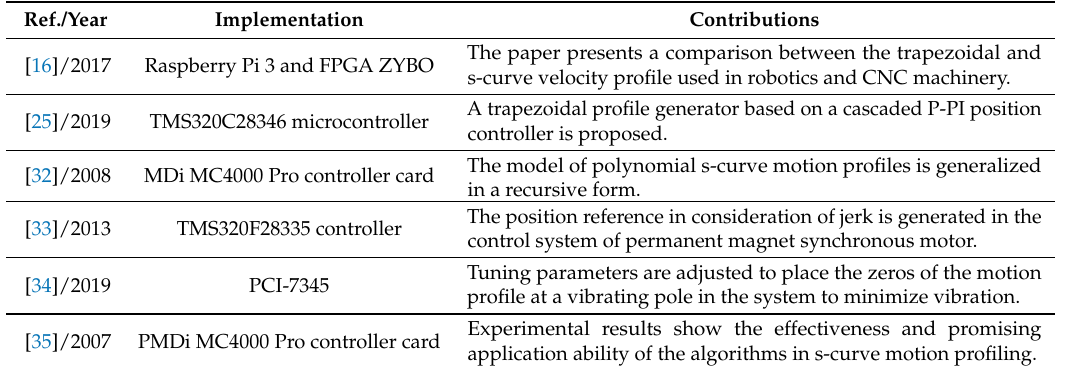
Table 2. Summary of the state of the